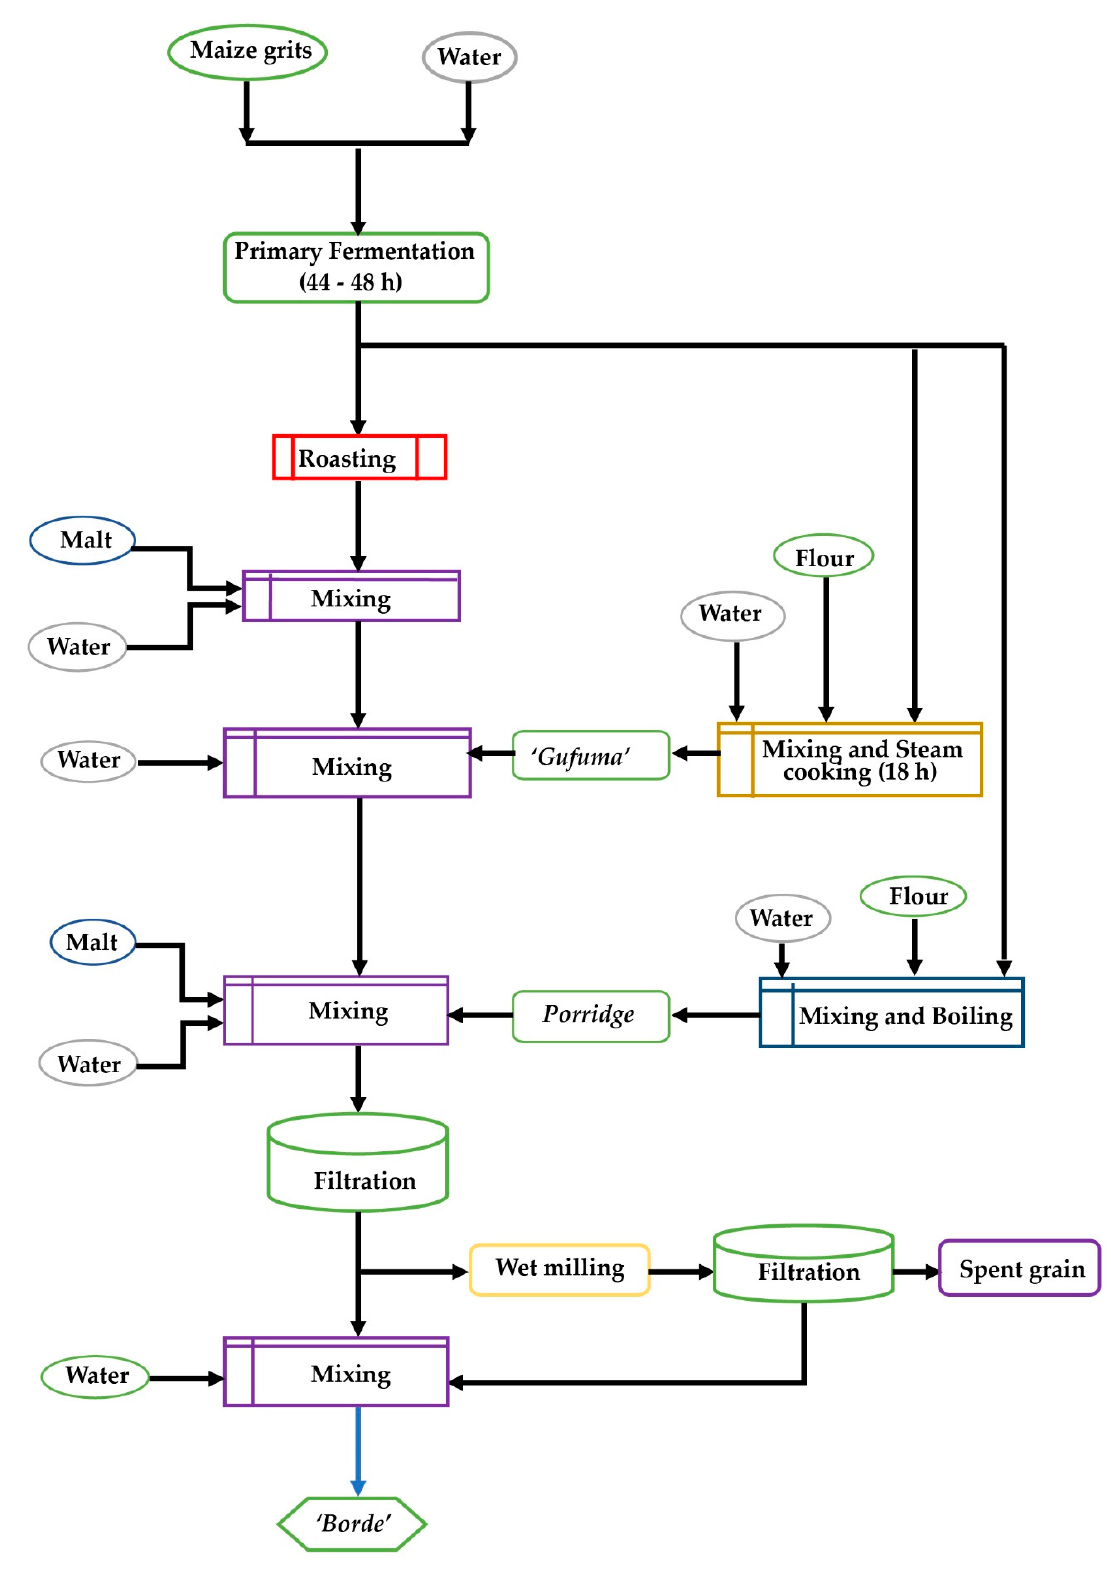
Figure 1. Borde processing flow chart [29].